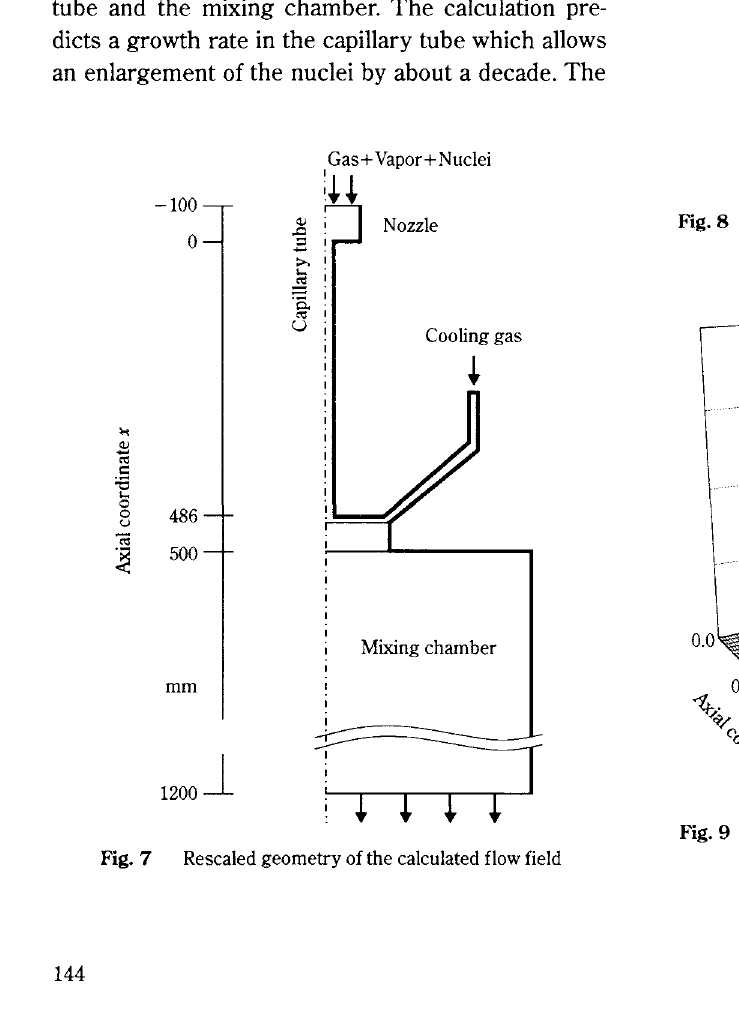
Rescaled geometry of the calculated flow field